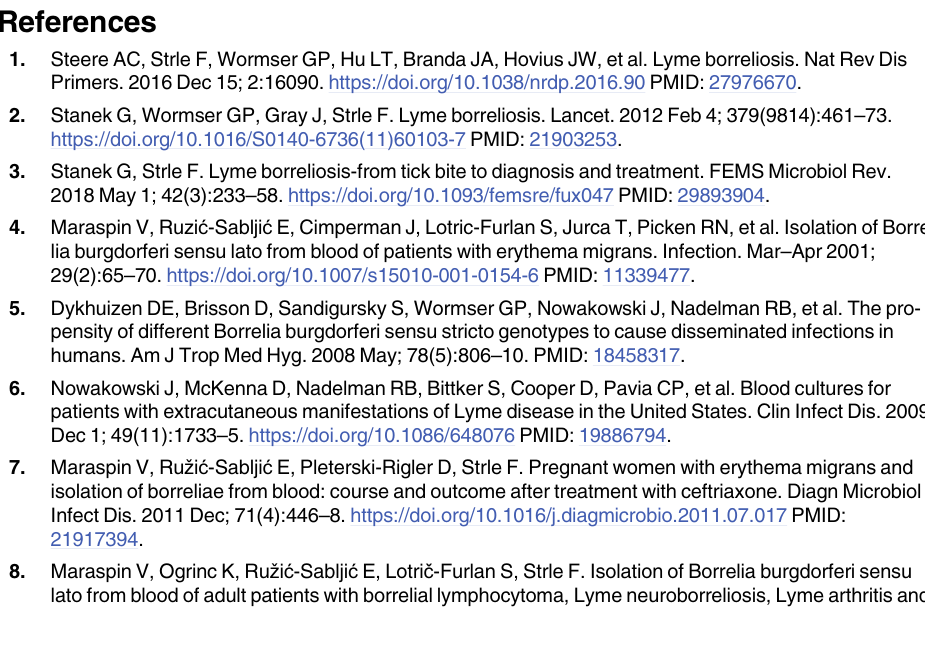
S5 Table. Variables related to isolation of Borrelia afzelii (n = 116) or Borrelia garinii (n = 37) from blood. S6 Table. Comparison of demographic, clinical, laboratory and microbiological findings according to isolation of Borrelia afzelii or Borrelia garinii from skin. S7 Table. Variables related to isolation of Borrelia afzelii (n = 116) or Borrelia garinii (n = 37) from